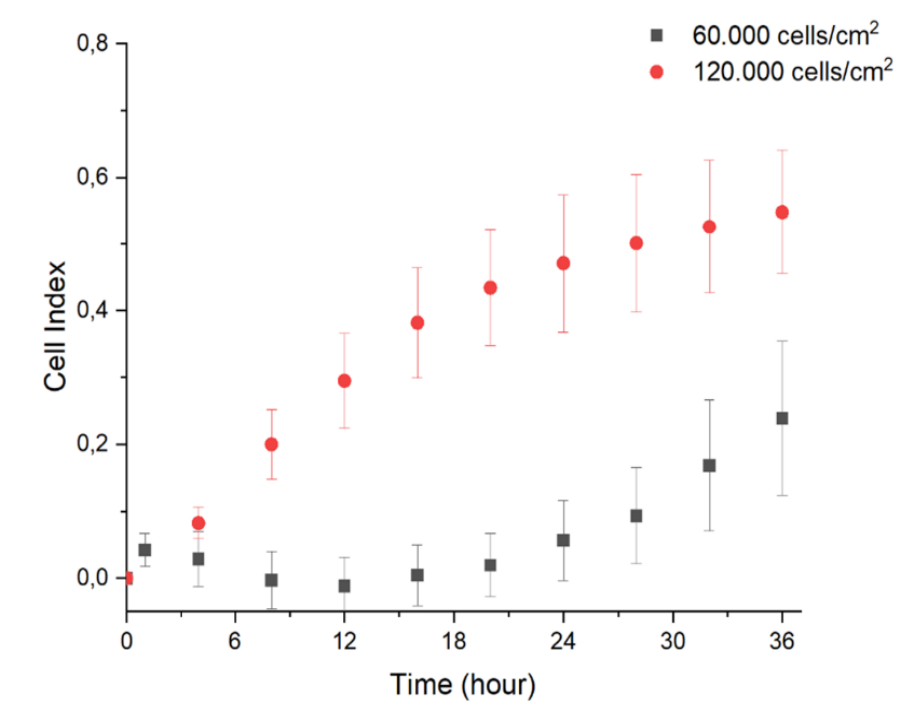
Figure S2. Cell Index vs. time for proliferating hVM1 Bcl-X cells/cm 2 and 120,000 cells/cm 2 . (Error bars: standard deviation, n = 3) The results indicate that 120,000 cells/cm 2 is the optimal cell seeding density for hVM1 Bcl-X All subsequent experiments shown in the paper were performed using this cell seeding